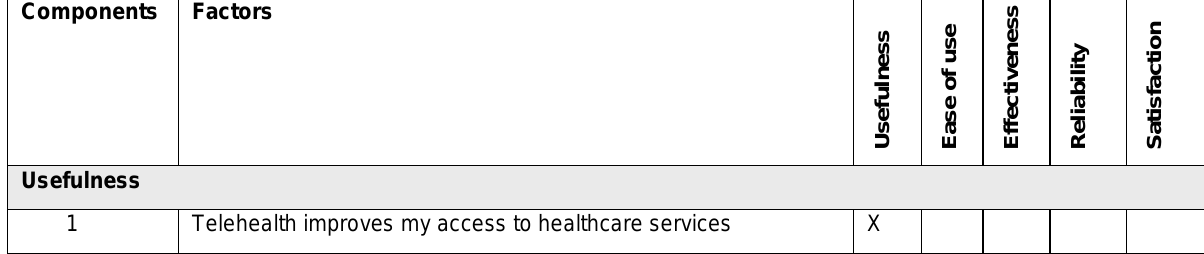
Table 2. Usability Components, Questionnaire Items, and Usability Factors